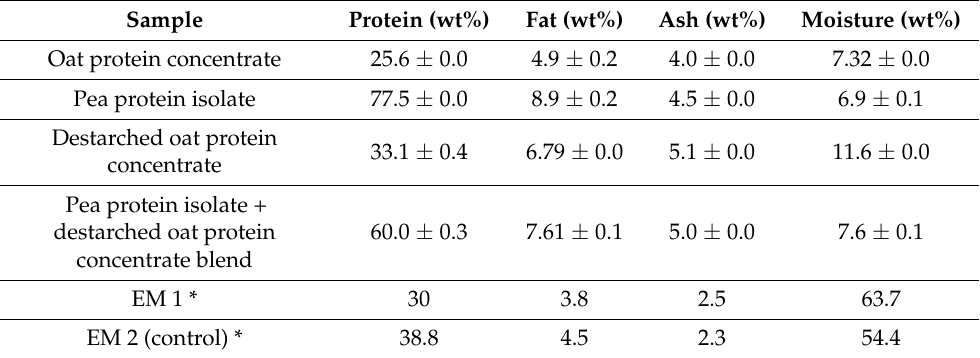
Table 2. The chemical composition of the commercial raw materials, destarched oat protein concen- trate, and a blend of these proteins. The calculated proximate compositions of the extrusion mixtures EM1 (destarched OPC + PPI) and EM2 (PPI) are shown. Sample Protein (wt%) Fat (wt%) Ash (wt%) Moisture (wt%) Oat protein